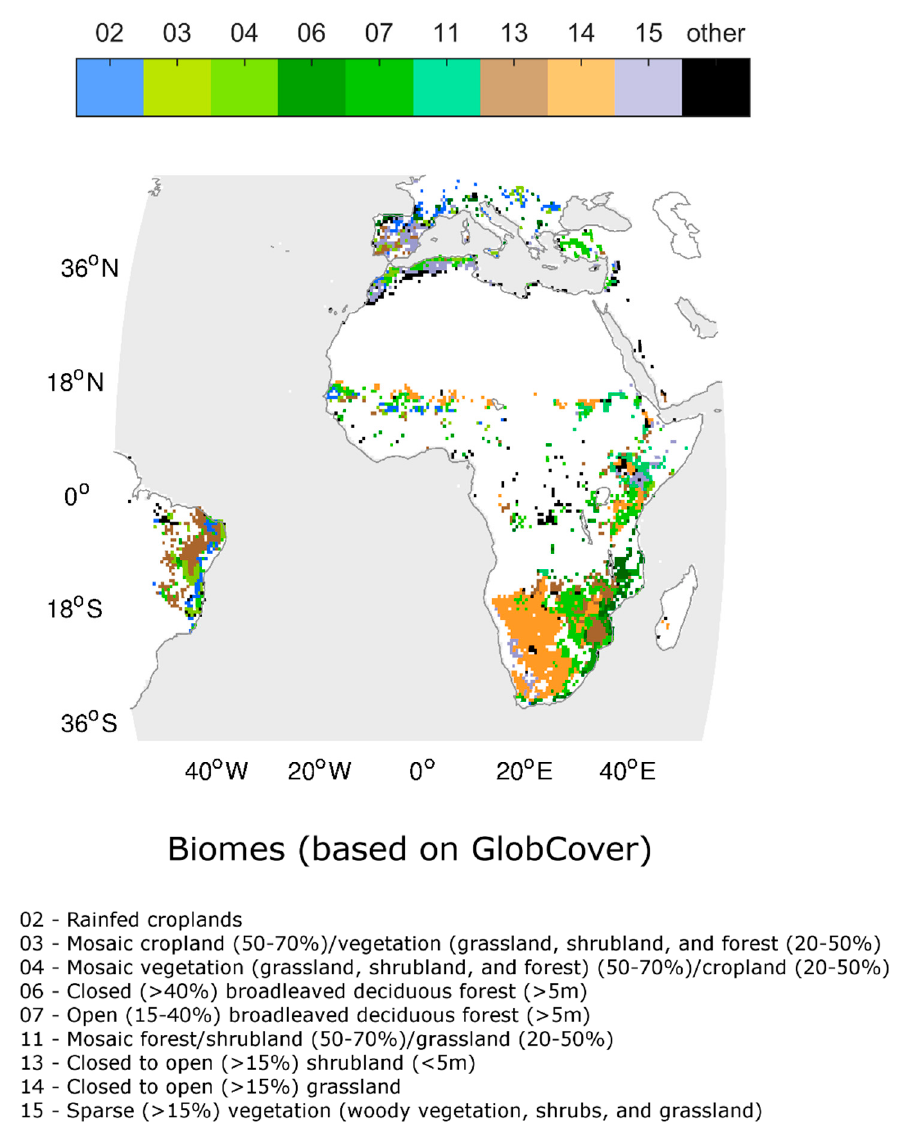
Figure 4. Advanced Along-Track Scanning Radiometer (AATSR) LST biome classification version 2 (ALB-2) derived from the GlobCover classification for pixels with significant correlation between VHI and SPEI.